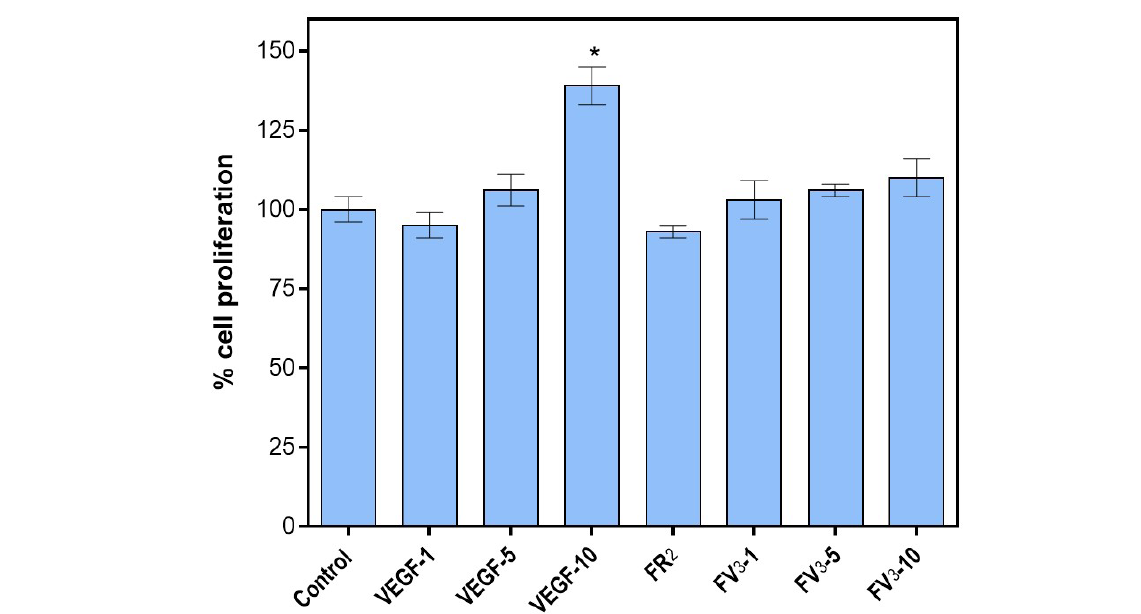
FIGURE 3 - Bioactivity of the VEGF released from nanoparticles by XTT. It was determined that both 1, 5 and 10 ng/mL free VEGF solutions (VEGF-1, VEGF-5, VEGF-10) or VEGF-loaded nanoparticles (FV 10 ng/mL concentration (FV -1, FV -5, FV -10) increased proliferation in HUVEC culture compared to the culture medium as 3 3 3 control. VEGF-free PCL nanoparticles (FR ) did not increase cell proliferation. *p <0.05 2